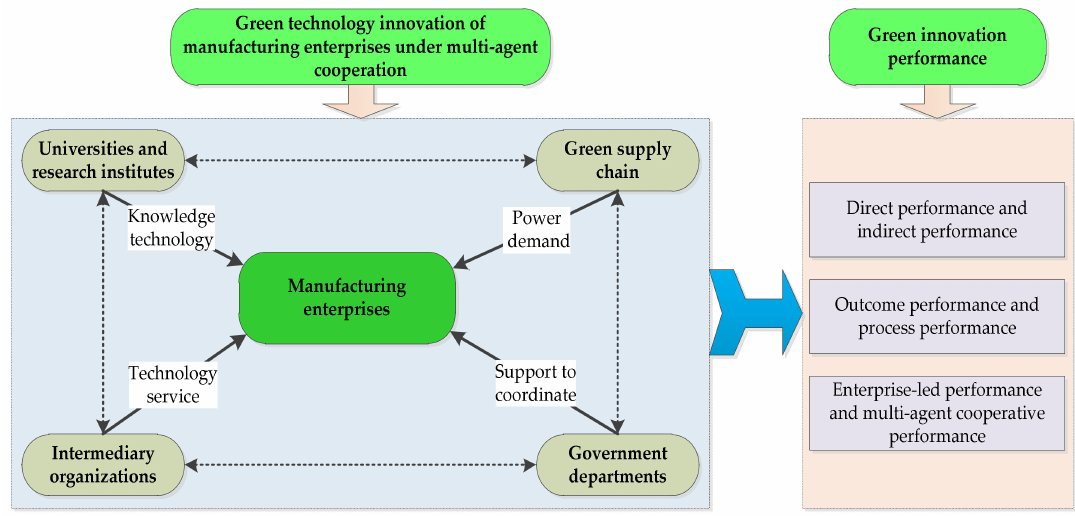
Figure 2. The performance formation framework of the green technology innovation performance of manufacturing enterprises under multi-agent